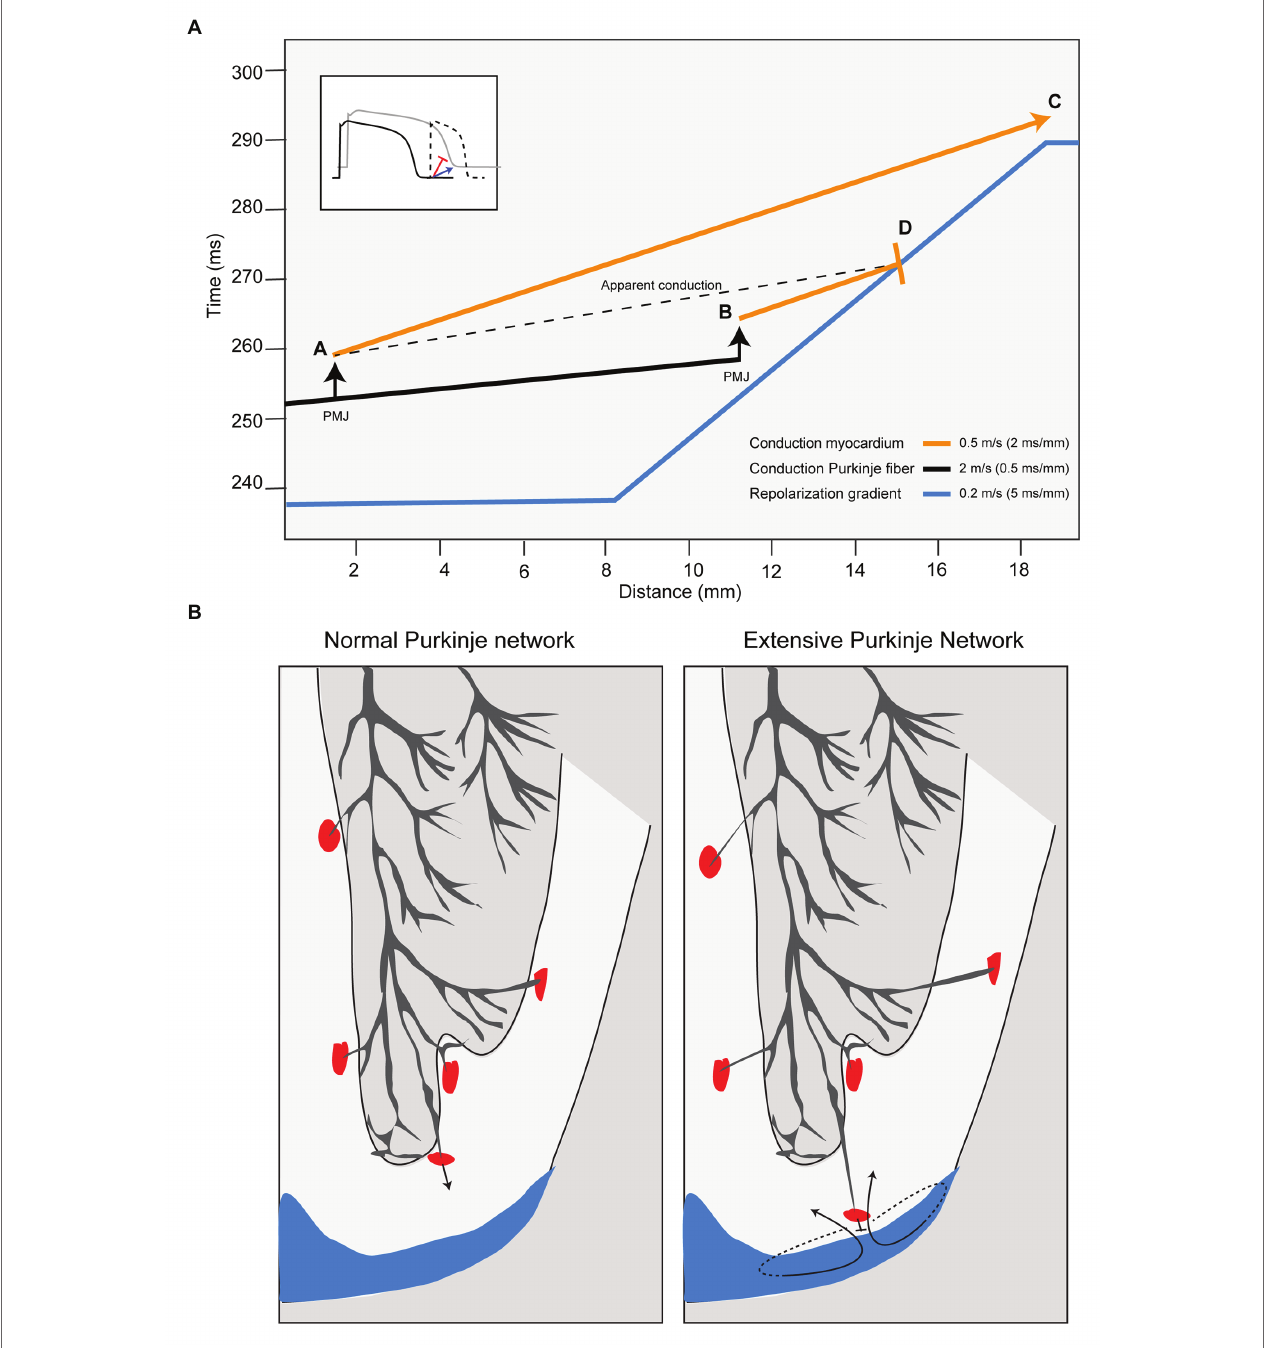
FIGURE 2 | Purkinje-muscle junctions (PMJs) close to repolarization gradients may cause reentrant arrhythmias. (A) The graph shows time (vertical axis) and myocardial distances (horizontal axis). The blue line represents the repolarization time along the myocardial axis of beat 1 (supposedly a sinus activation). The orange and black lines show activation time along the myocardial axis of beat 2 (a ventricular premature activation). The orange line represents conduction through working myocardium and the black line through Purkinje fibers. If the PMJ activates the working myocardium far from the repolarization gradient (location A) the activation front propagates at low speed toward repolarization gradient, which will have disappeared when the activation front arrives (location C). If the PMJ activates the working myocardium close to the repolarization front (location B), the activation front meets still depolarized myocardium and conduction will block (location D) setting the stage for re-entry. Inset: A slowly conducting premature activation front (blue) arrives late at the site of prolonged repolarization causing activation whereas a fast conducting activation front (red) results in unidirectional block and re-entry. PMJ, Purkinje-muscle junction. (B) In the normal human heart, the Purkinje system is located at the endocardial side of the ventricular myocardium (left panel). If the Purkinje system penetrates into the transmural wall of the ventricle, the change is higher the working myocardium is activated close to depolarized myocardium (blue) and conduction block